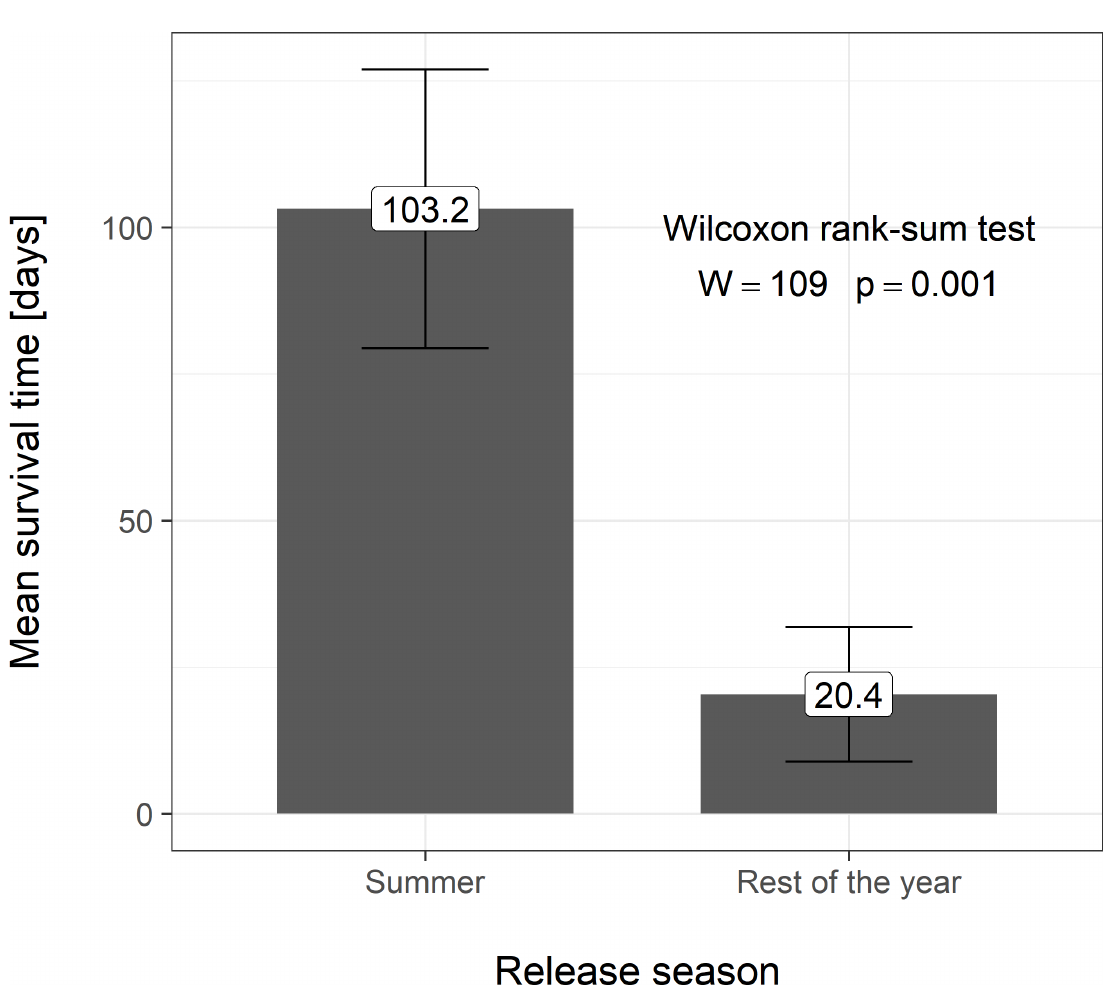
Fig 3. Survival days in relation to the release date of brown hare. The labels above the bars show the mean value of each variant. Error bars depict mean ± standard error.